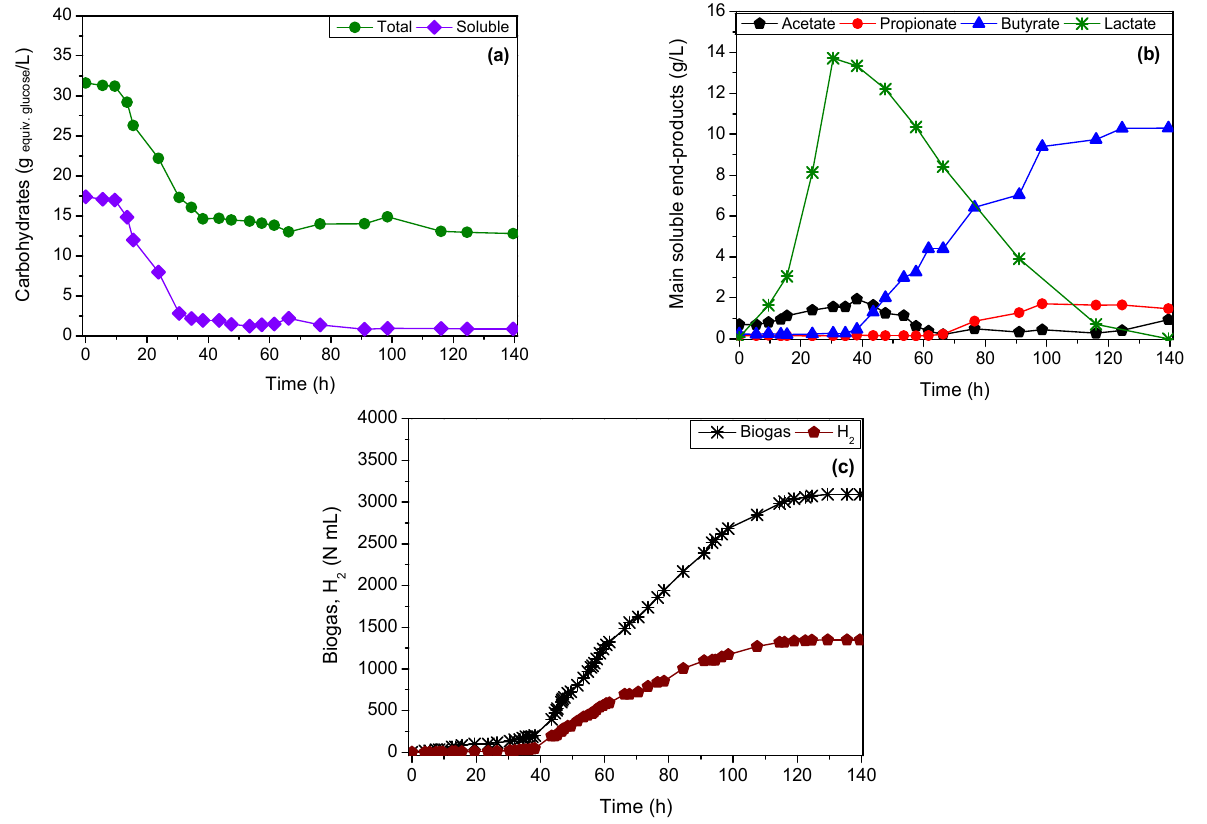
Figure 4. ( a ) Consumption of carbohydrates; ( b ) evolution of main VFAs and lactic acid and ( c ) gaseous products (biogas and hydrogen) using heat pre-treated enriched anaerobic sludge, at pH 5.5.